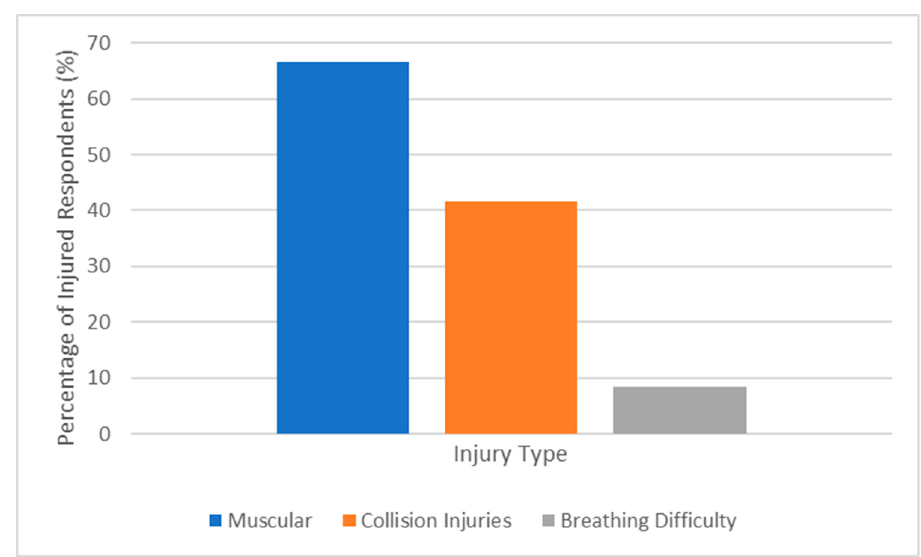
Figure 2. Driver injury types—percentage of injured Figure 2 . Driver injury types—percentage of injured respondents.